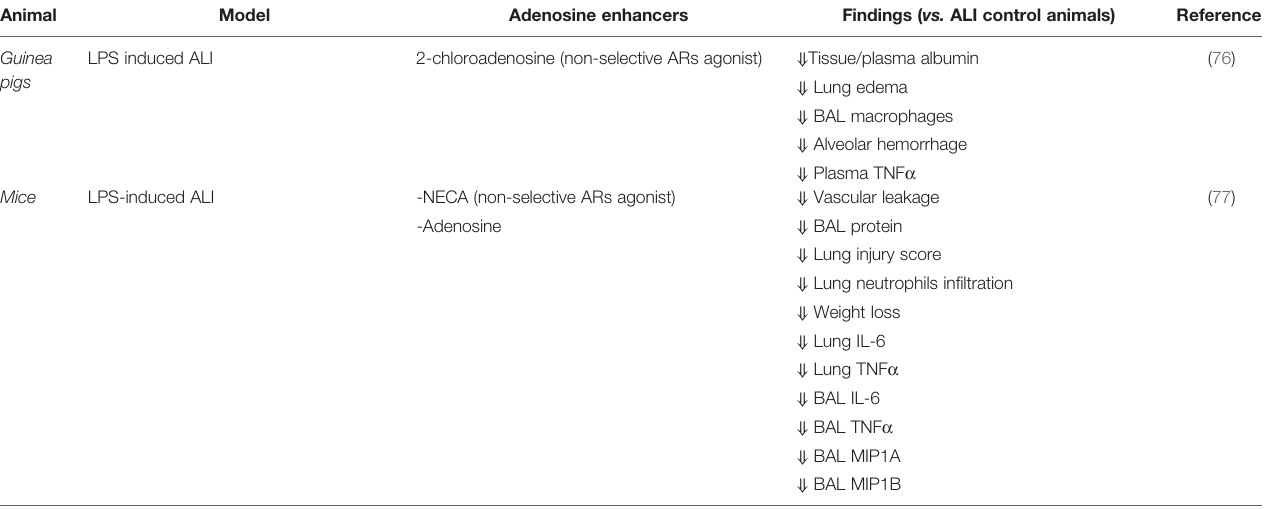
TABLE 1 | Adenosine signaling enhancement in acute lung injury animal models. Animal Model Adenosine enhancers Findings ( vs. ALI control animals)